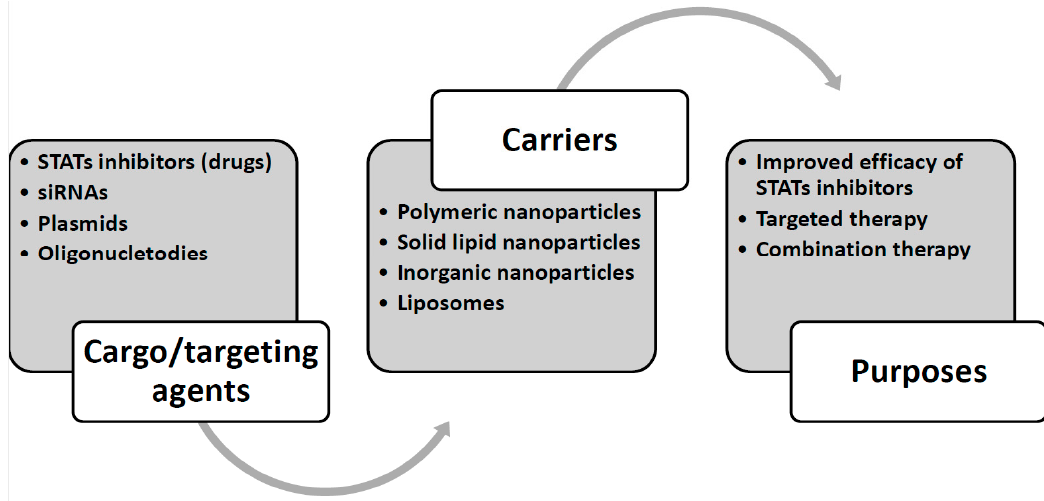
Figure 1. Application of nanoparticles in targeting STATs.